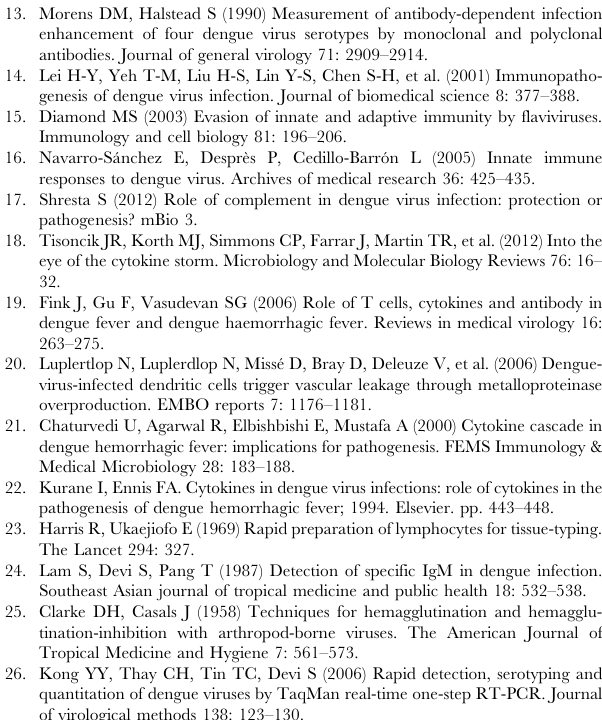
Figure S4 Inhibition of matrix metalloproteases canon- ical pathway from Ingenuity Pathway Analysis. MT-MMP complex includes MMP15 , MMP16 , and MMP24 , among others, and these three were down-regulated in asymptomatic individuals.